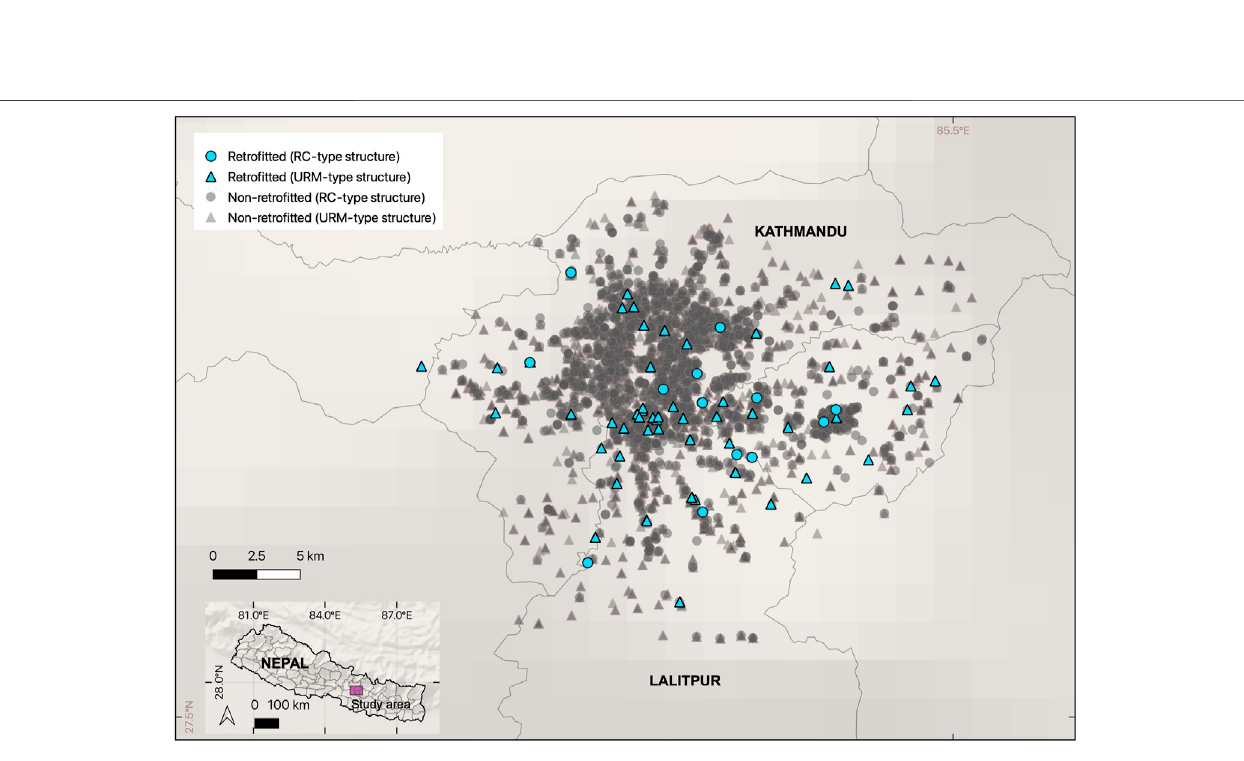
Frontiers in Earth Science |